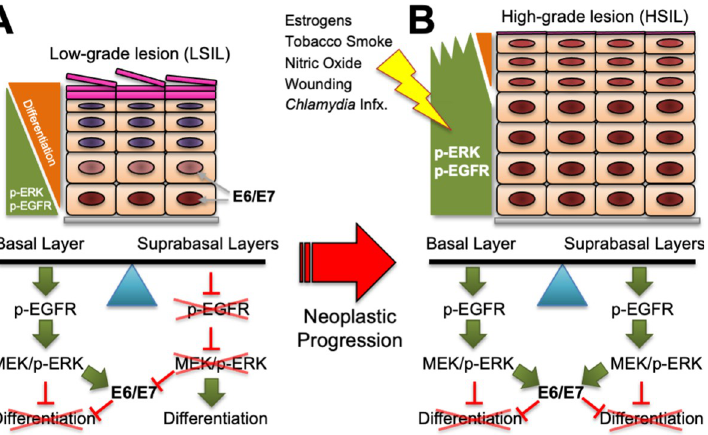
Fig 10. Model of the Proposed Mechanism of hr-HPV Oncogene Regulation by the MEK/ERK Signaling Pathway. A working model depicting the coordination of MEK/ERK signaling and hr-HPV E6/E7 oncoprotein expression leading to progressive loss of differentiation in early to late hr-HPV(+) neoplastic progression (adapted from [27]). (A) EGFR/MEK/ERK signaling in the basal layer is important for hr-HPV oncogene expression, which feeds back into enhancing ERK1/2 signaling and dampening terminal differentiation. In contrast, suppressed EGFR/MEK/ERK signaling in the suprabasal layers leads to reduced E6/E7 oncogene expression, permitting epithelial differentiation and expression of hr-HPV late proteins in LSIL. (B) Consistent with our data and reports that EGFR signaling and levels of p-ERK1/2 increase concomitant with HPV oncogene expression during progression from LSIL to HSIL, we find EGFR stimulation enhances E6/E7 oncogene expression. Our data predict that shifting the balance toward increased ERK1/2 signaling in suprabasal layers would cause increased E6/E7 oncogene expression and further loss of